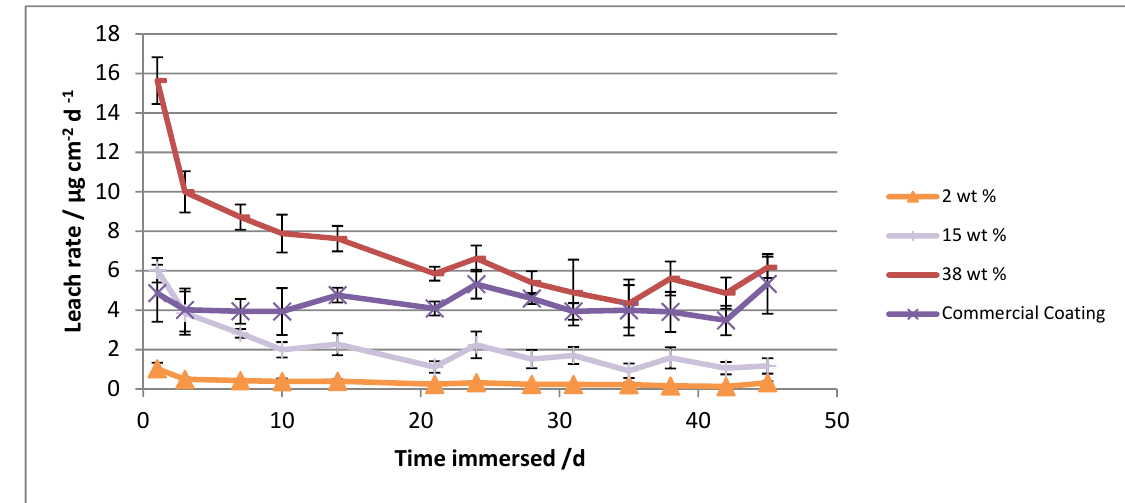
Figure 2. The leach rate of Econea ® , from synthetic standards and a commercial coating, in artificial sea water. [The number of replicates per synthetic standard/commercial coating is 3. The error bars represent ± standard deviation].